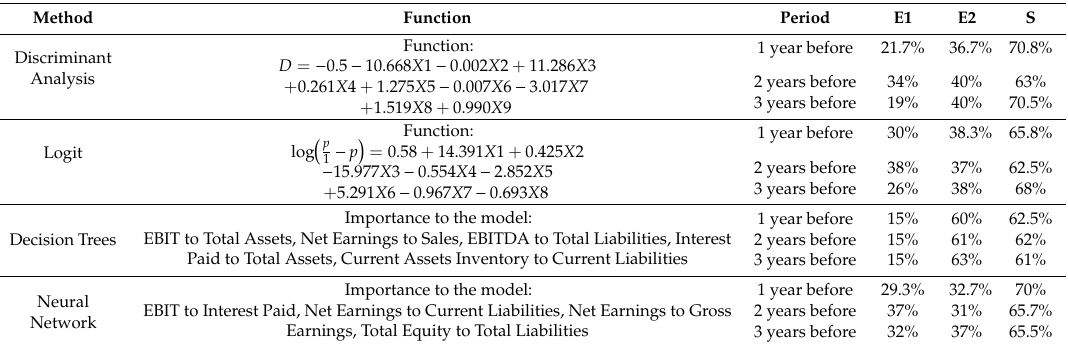
Table 10. Aggregate classification